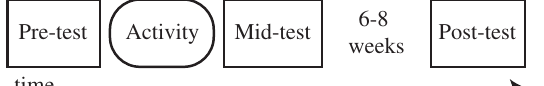
FIG. 2. The timeline for the